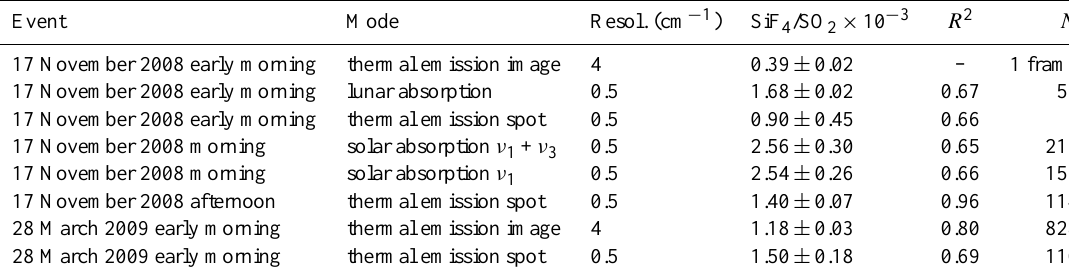
Table 2. Results of the SiF 4 /SO 2 ratios obtained from different measurement strategies.